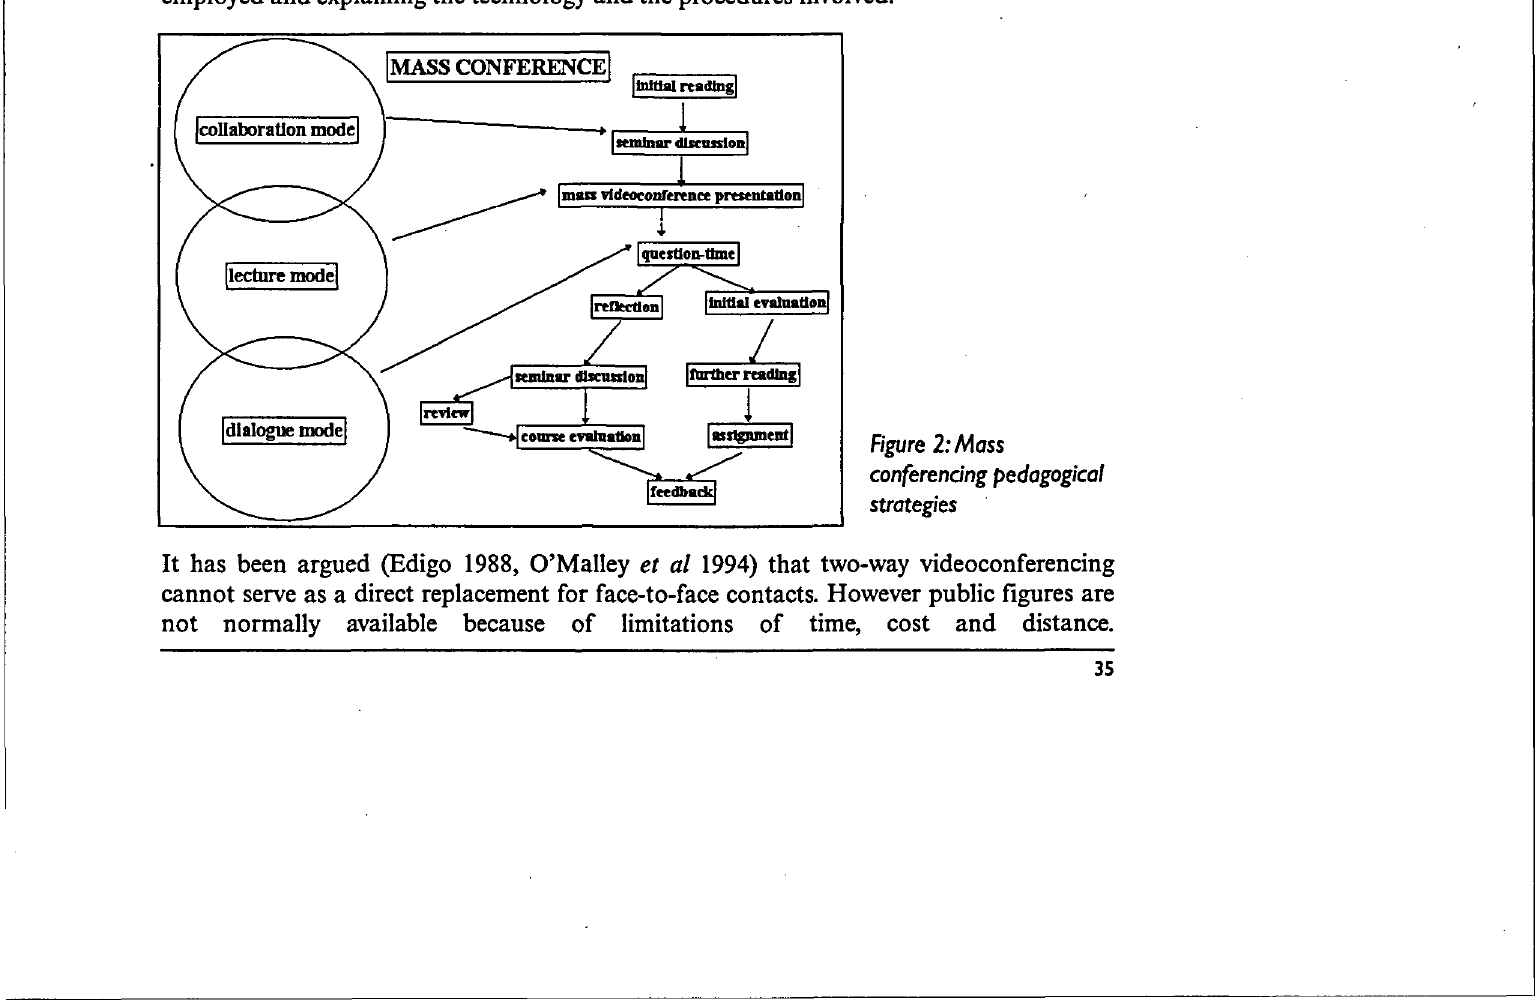
figure 2: Mass conferencing pedagogical